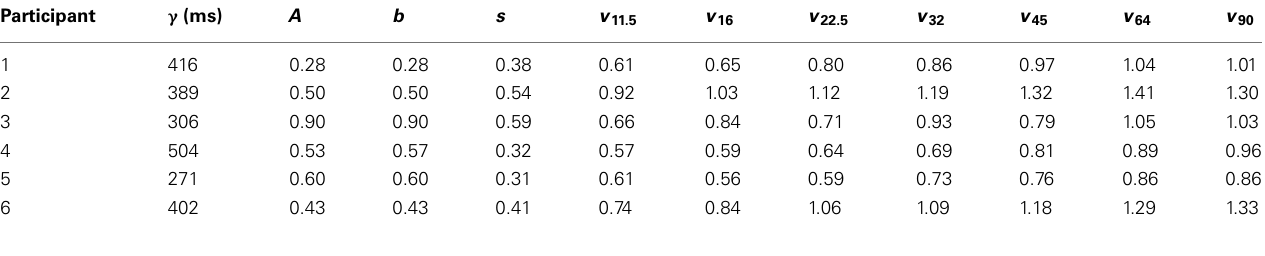
Table 4 | Best fitting LBA model parameters for the data of Experiment 1.